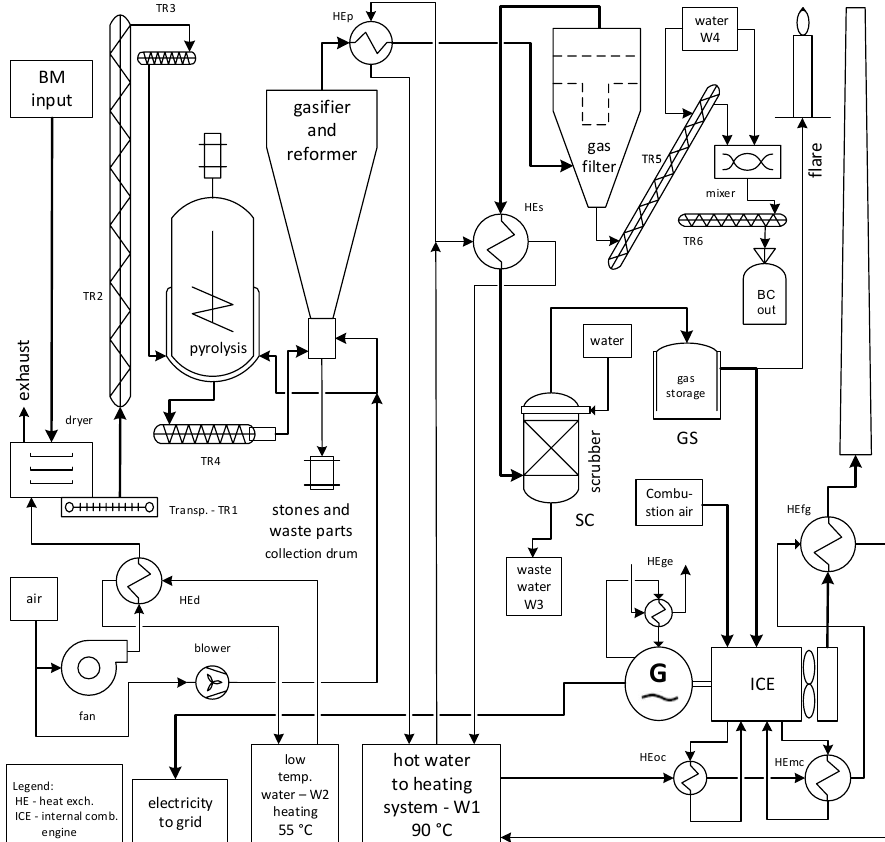
Figure 1. Process arrangement of CHPC technology, cogeneration of heat, power and char. After fresh BM drying, on a Figure 2, a hot and relatively dry (calculate on 6% of WC) BM enters the pyrolysis process. Autothermal pyrolysis process runs at Equivalence Ratio (ER) of 0.093—(ER—actual air-fuel ratio to the stoichiometric air-fuel ratio for combustion). Means the addition of air controls the process to run in a reductive atmosphere and generates enough energy to maintain the process at θ py = 450 ◦ C. Complete pyrolysis products, char (CH) and whole pyrolysis gases (PG) enter the reformer/gasifier reactor via screw conveyor (TR 4, Figure 1). At reformer entrance, a separation device removes heavy particles (stones, glass, metal parts . . . ) from CH stream. Particles are collected in a drum at the bottom. In the same separator, a second portion or gasification air is added to the input stream. Exponential cone at the spouted bed gasifier construction input causes a high velocity of the gas stream assures long residence time for large CH particle to react